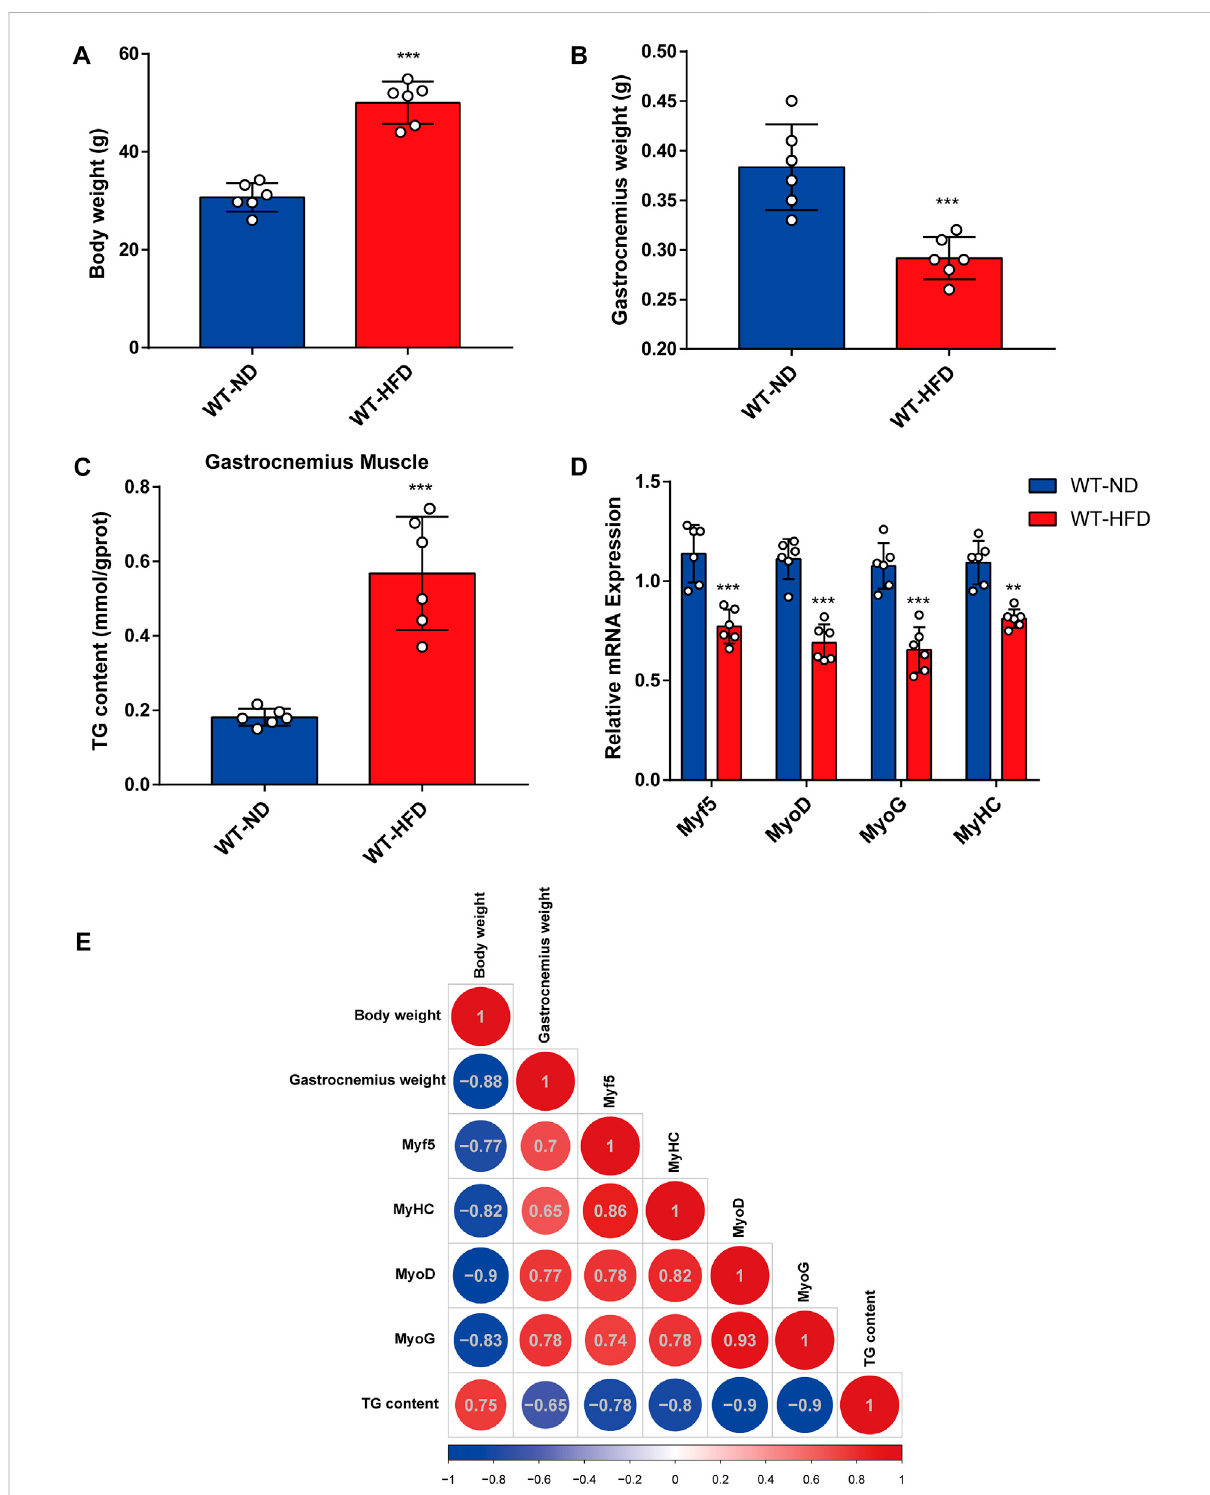
FIGURE 1 Correlation between obesity and myogenic differentiation. Six-week-old male mice were divided into two groups, each fed with normal chow and high-fat diet for 8 weeks. (A) Body weight comparison. (B) Gastrocnemius muscle weight (GW) comparison. (C) Comparison of triglyceride (TG) levels in gastrocnemius muscles from the ND-fed and HFD-fed mice as assessed using the Triglyceride Quanti fi cation Kit. (D) The mRNA expression levels of myogenesis-relatedgenes( Myf5 , MyoD , MyoG ,and MyHC )intheND-fedandHFD-fedmiceasmeasuredthroughquantitativereal-timePCR(qPCR). (E) Correlationheatmap(Pearsoncorrelation)ofbodyweight,TGlevel,GW,andmRNAlevelsofmyogenesis-relatedgenes.Positiveandnegativecorrelations are shown by red and blue colors, respectively. Date are shown as mean ± SEM ( n = 6 for each group). * p < 0.05, ** p < 0.01, and *** p < 0.001 vs.